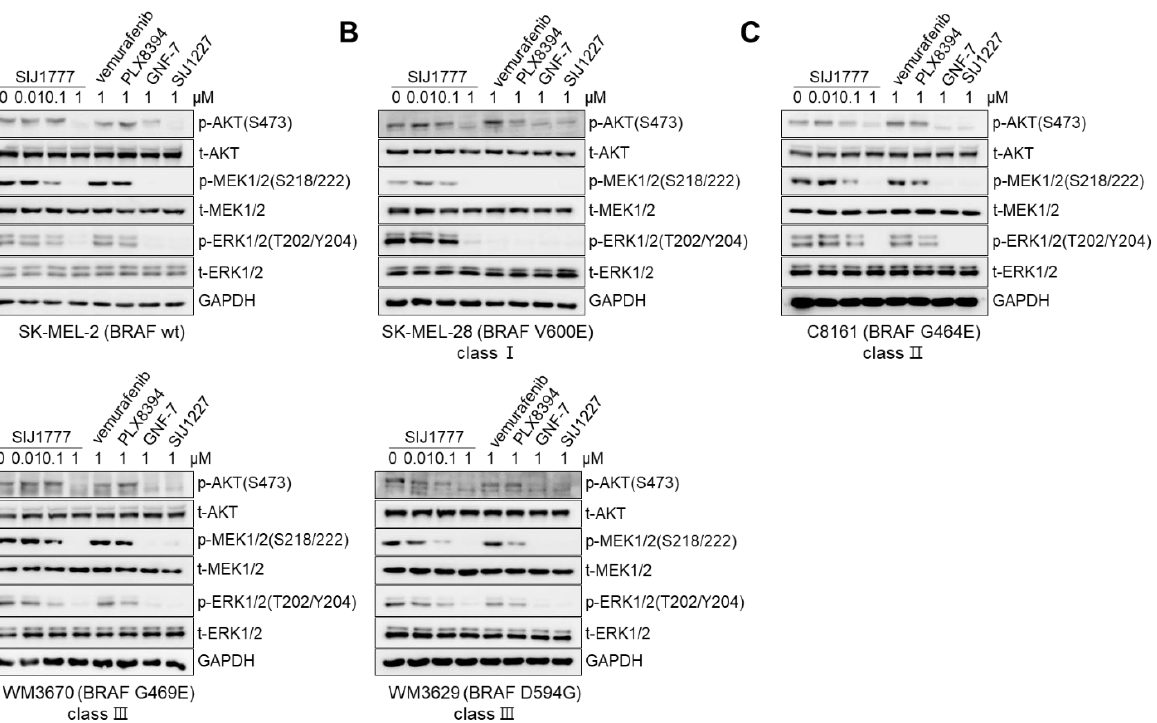
Figure 3. The effect of SIJ1777 on AKT and MAPK signaling pathways in melanoma cell lines harboring various BRAF mutation status ( A ) SK-MEL-2 (wt) ( B ) SK-MEL-28 (class I) ( C ) C8161 (class II) ( D ) WM3670, WM3629 (class III). Cells were treated with 0.01, 0.1, 1 μM of SIJ1777, and 1 μM of vemurafenib, PLX8394, GNF-7, and SIJ1227 for 2 h. Cell lysates were subjected to western blot analysis to estimate the phospho- or total- form of AKT, MEK, ERK levels, and GAPDH was used as the internal loading controls.